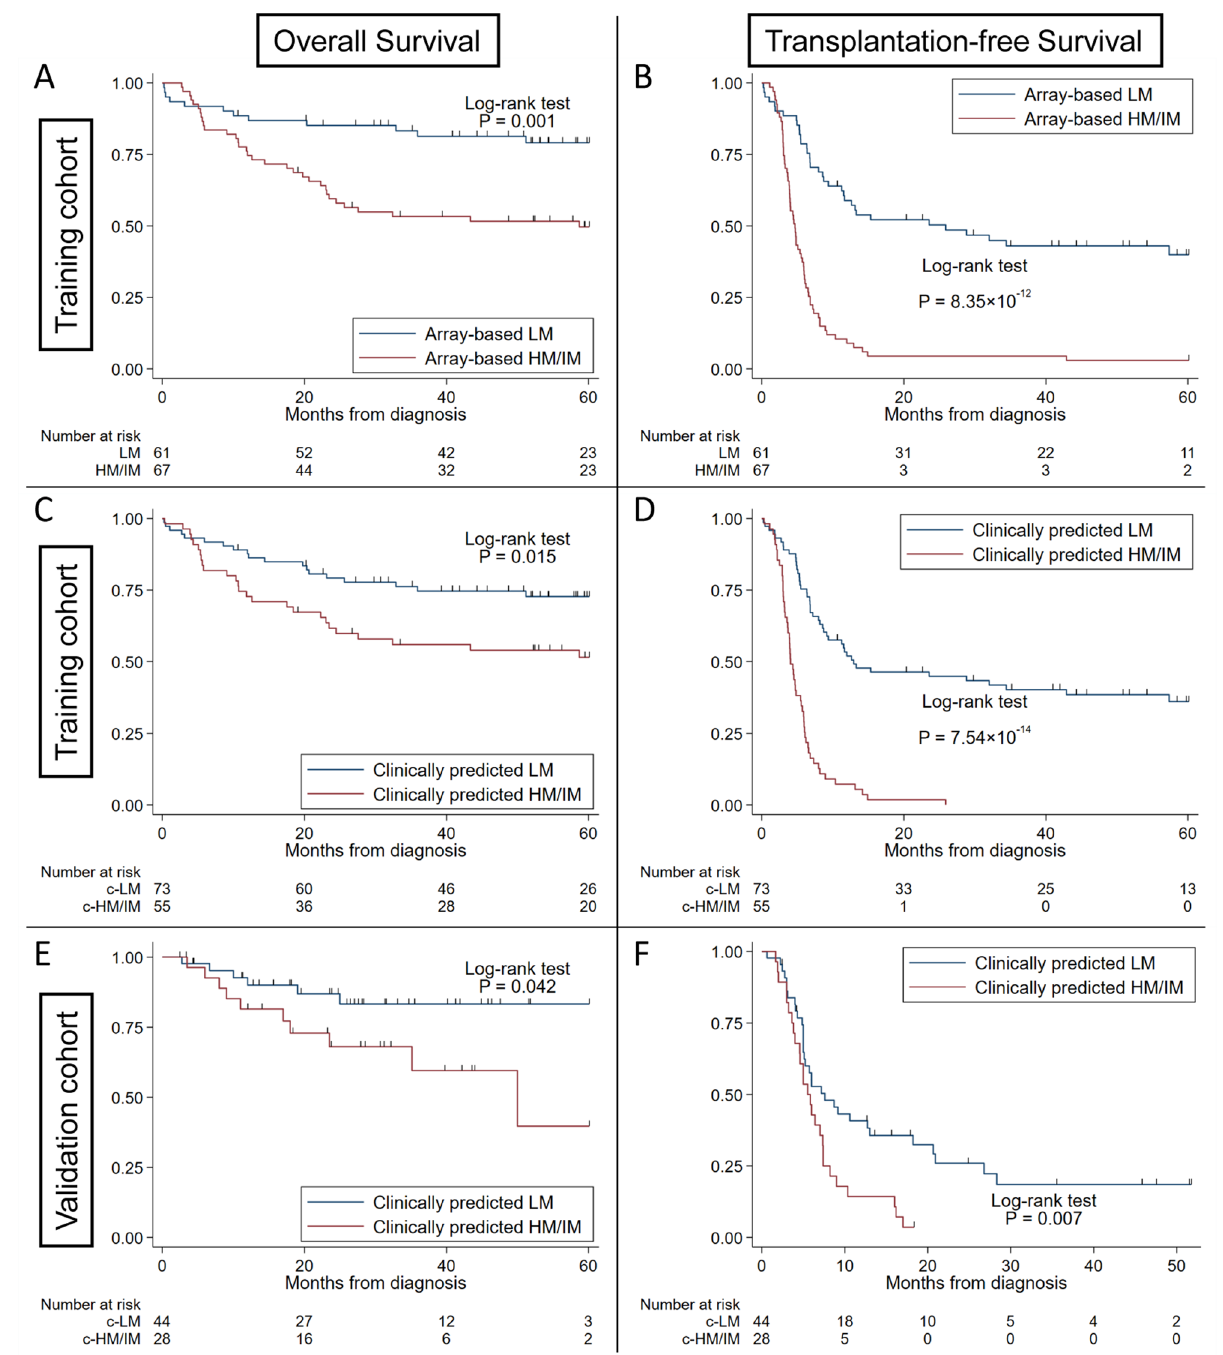
Figure 3. Overall survival and transplantation-free survival based on dichotomized DNA methylation classification. ( A ) Overall survival (OS) by array-based DNA methylation classification in the training cohort. ( B ) Transplantation-free survival (TFS) by array-based DNA methylation classification in the training cohort. ( C ) OS by clinically predicted methylation classification in the training cohort. ( D ) TFS by clinically predicted methylation classification in the training cohort. ( E ) OS in the validation cohort. ( F ) TFS in the validation cohort. Survival curves were estimated using the Kaplan–Meier method, and statistical tests were performed using the log-rank test. Array-based HM/IM or LM was significantly associated with both OS and TFS in the training cohort (P = 0.001 and 8.35 × 10 −12 ). Clinically predicted HM/IM or LM was significantly associated with both OS and TFS in the training cohort (P = 0.015 and 7.54 × 10 −14 , respectively) and associated with both OS and TFS in the validation cohort (P = 0.042 and 0.007, respectively). OS overall survival, TFS transplantation- free